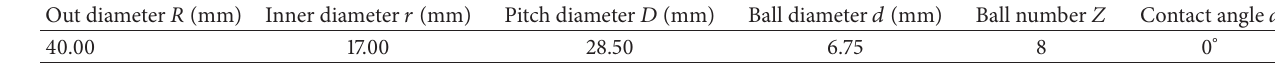
Table 3: The main parameters of the rolling bearing of SKF6203.